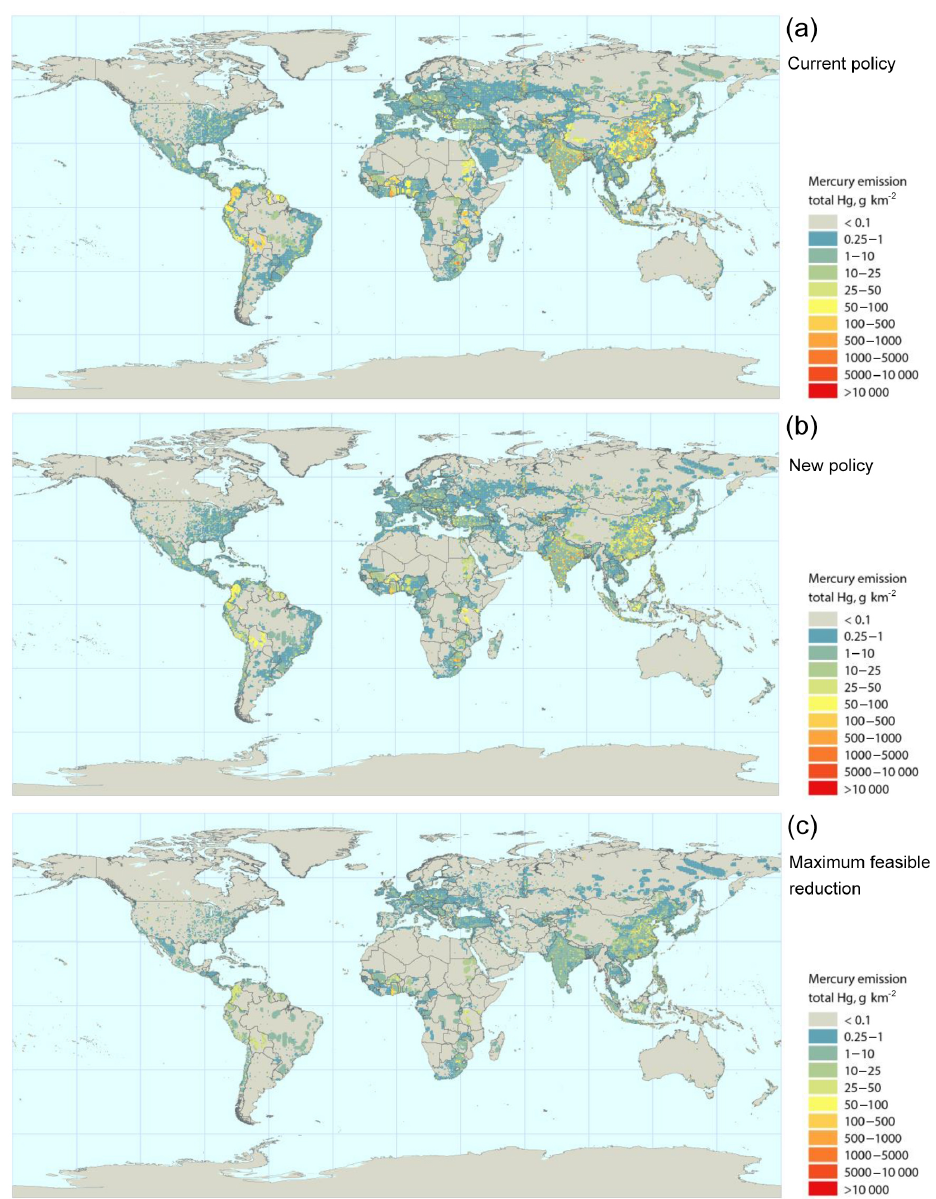
Figure 4. (a) Spatial distribution of mercury emissions in 2035 according the CP scenario. (b) Spatial distribution of mercury emissions in 2035 according the NP scenario. (c) Spatial distribution of mercury emissions in 2035 according to the MFR